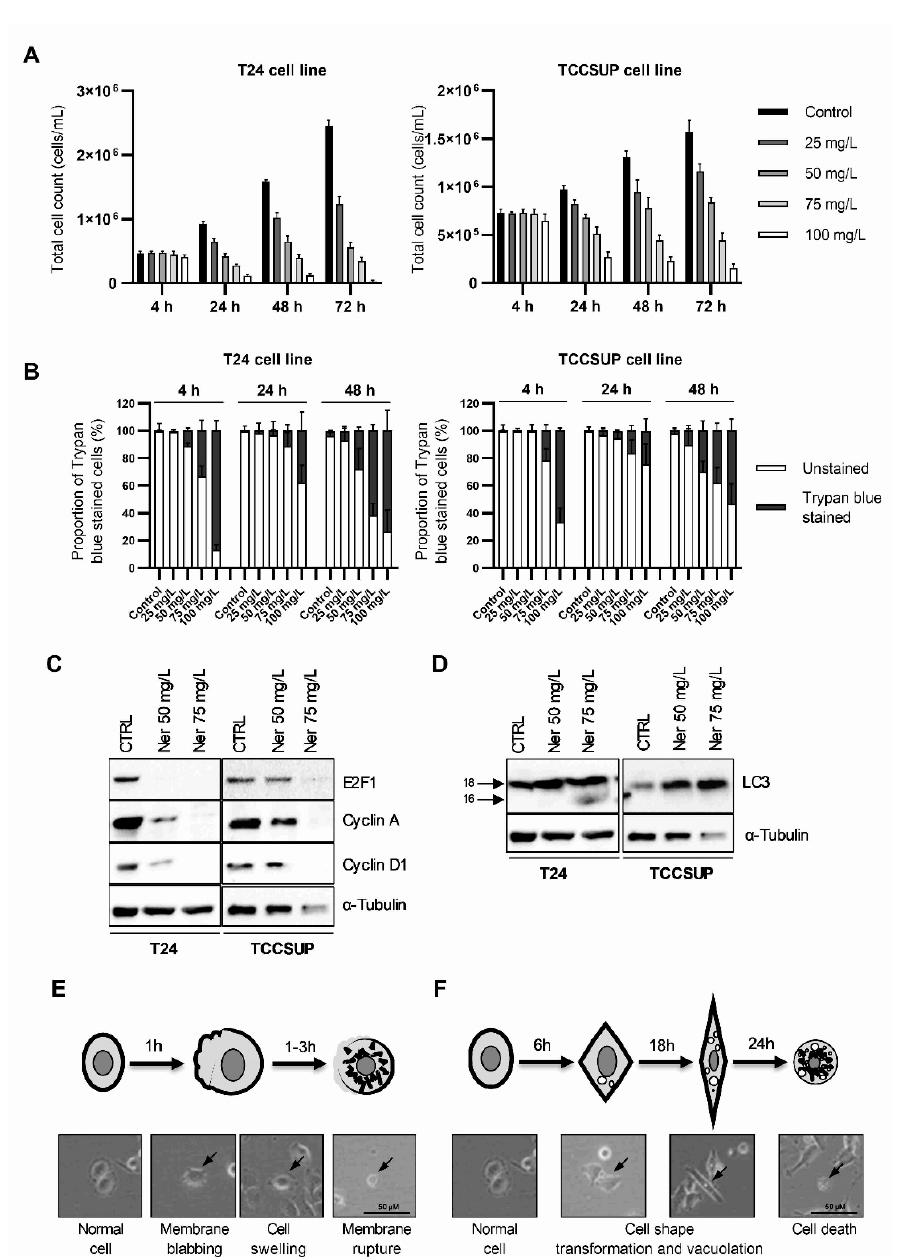
Figure 1. Nerolidol induces two cell death periods with distinct cell morphologies. ( A ) T24 (left) and TCCSUP (right) total cell counts at 4, 24, 48, and 72 h after nerolidol was administered at 25, 50, 75, and 100 mg/L. ( B ) T24 (left) and TCCSUP (right) cell viability was determined at 4, 24, and 48 h after nerolidol was administered at 25, 50, 75, and 100 mg/L. Cell viability was determined by cell counting after trypan blue staining and presented as a share of stained cells in the total cell count (100%) for each measurement. Stained cells were considered not viable. ( C ) Immunostaining of cell cycle markers E2F1, cyclin A, and cyclin D1 in T24 and TCCSUP cell lines after treatment with 50 and 75 mg/L of nerolidol for 24 h analyzed by WB. ( D ) Expression and processing of autophagy marker LC3 in T24 and TCCSUP cell lines after treatment with 50 and 75 mg/L of nerolidol for 24 h analyzed by WB. ( E ) Schematic representation of changes in cell morphology that describe early induced cell death with an indicated timeline corroborated by cell photographs. ( F ) Schematic representation of changes in cell morphology that describe late cell death event with an indicated timeline corroborated by cell photographs (arrows indicate cells with described morphological features). The uncropped blots and molecular weight markers are shown in Supplementary File